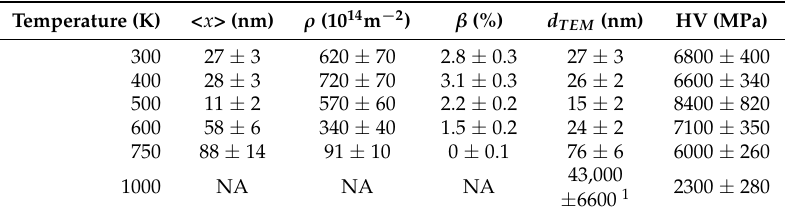
Figure 10. Dislocation density ( ρ ) and twin fault probability ( β ) for the “es” side of the film CYS04 versus the annealing temperature. The line serves as a guide for the eye only. Table 4. The microstructural parameters and the hardness of the samples deposited from the bath containing 0.4 g/L cysteine and heat treated up to different temperatures. Only the electrolyte side (es) of the samples was investigated. The table contains the mean crystallite size (< x >), the dislocation density ( ρ ) and the twin fault probability ( β ) obtained XLPA, the mean grain size obtained by TEM ( d TEM ) and the Vickers hardness